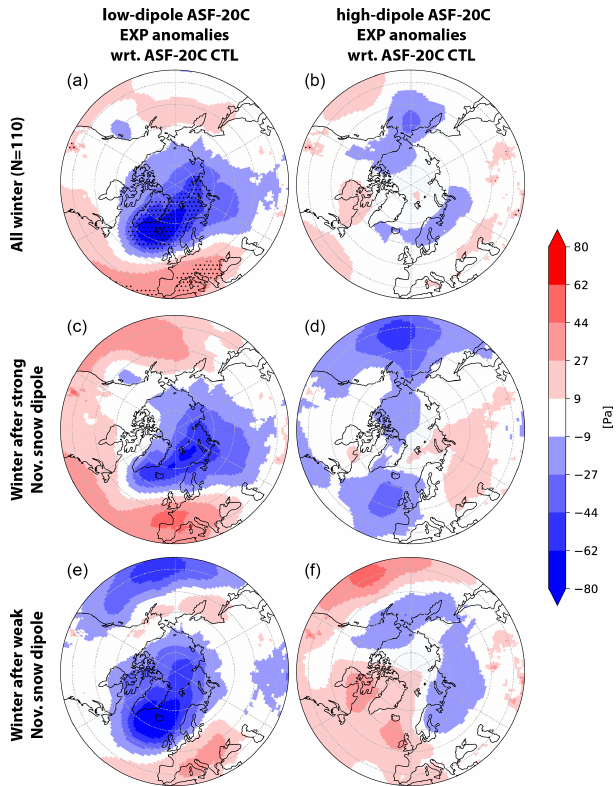
Figure 10. Mean sea level pressure [Pa] DJF anomalies for the period 1901–2010 between (a) low-dipole ASF-20C EXP ensem- ble mean and ASF-20C CTL ensemble mean (subsampled from 21 CTL members) and (b) high-dipole ASF-20C EXP ensemble mean and ASF-20C CTL ensemble mean (subsampled from 21 CTL members). Stippled areas represent 90% significance. Panel (c) rep- resents differences between low-dipole ASF-20C EXP ensemble mean and ASF-20C CTL ensemble mean DJF seasons after posi- tive snow dipole in ERA20C 1 November snow depth (see Fig. 1a). Panel (d) as panel (c) but for the high-dipole ASF-20C EXP ensem- ble mean. Panels (e) and (f) the same as panels (c) and (d) but for seasons after negative snow dipole in ERA20C 1 November snow